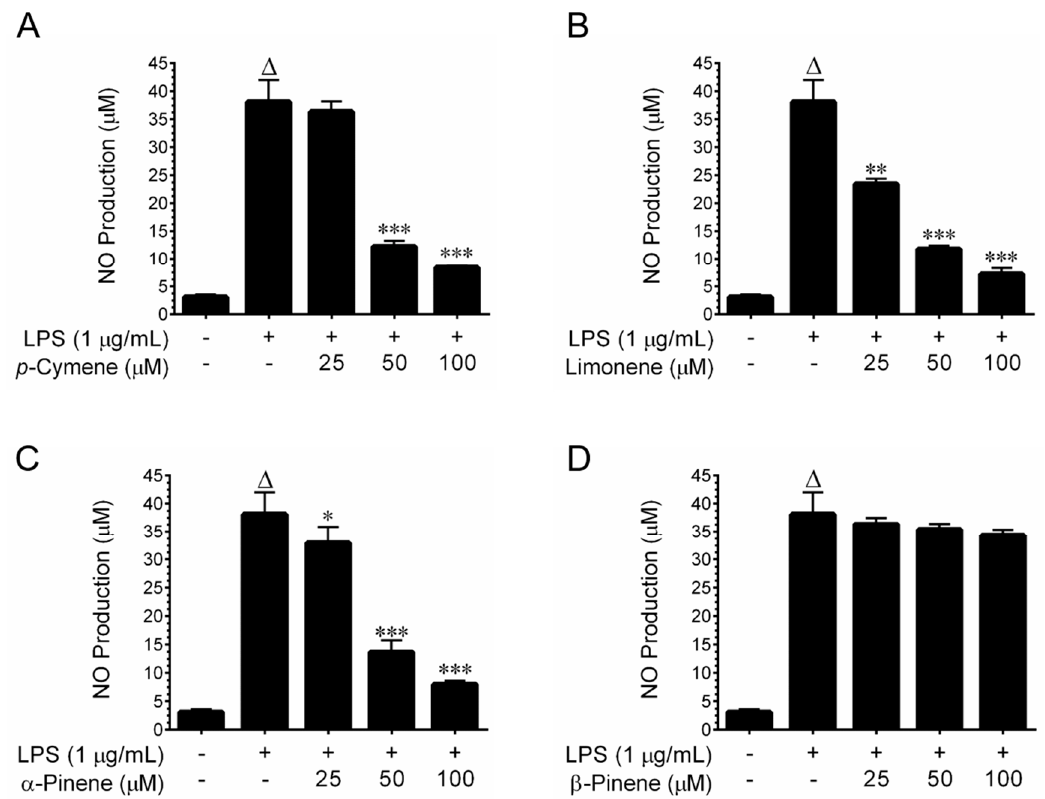
Figure 5. Effect of p -cymene, α -pinene, β -pinene, and limonene on LPS-induced NO production. RAW 264.7 cells were stimulated with LPS (1 μ g/mL) and incubated with the presence or absence of increasing concentrations of test compounds (25–100 μ M) and in the presence of 1 μ g/mL LPS for 24 h. ( A – D ) The nitrite concentration in the culture media was determined by the Griess reagent assay. Data are reported as mean ± SD of three independent experiments. Δ p < 0.001 indicates a significant difference between the control and LPS-only treated groups. * p < 0.05, ** p < 0.01, and *** p < 0.001 show significant differences between the LPS-alone and GTEO treatment groups.